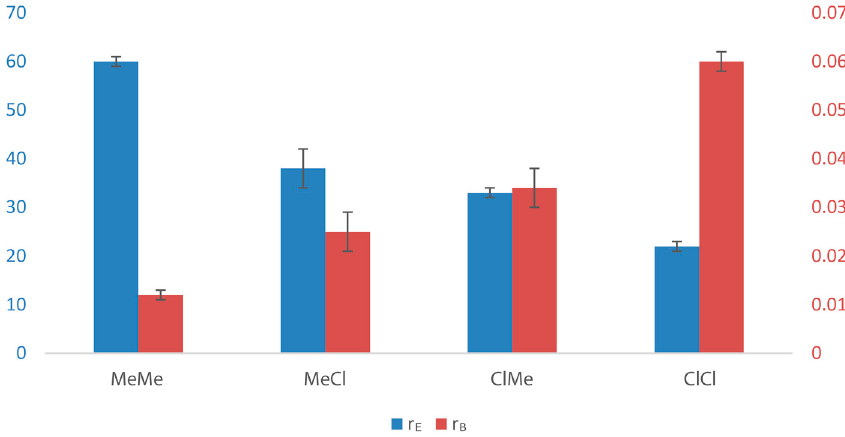
Figure 2. Trends in r E and r B for catalysts R 1 R 2 (see Table 1) .